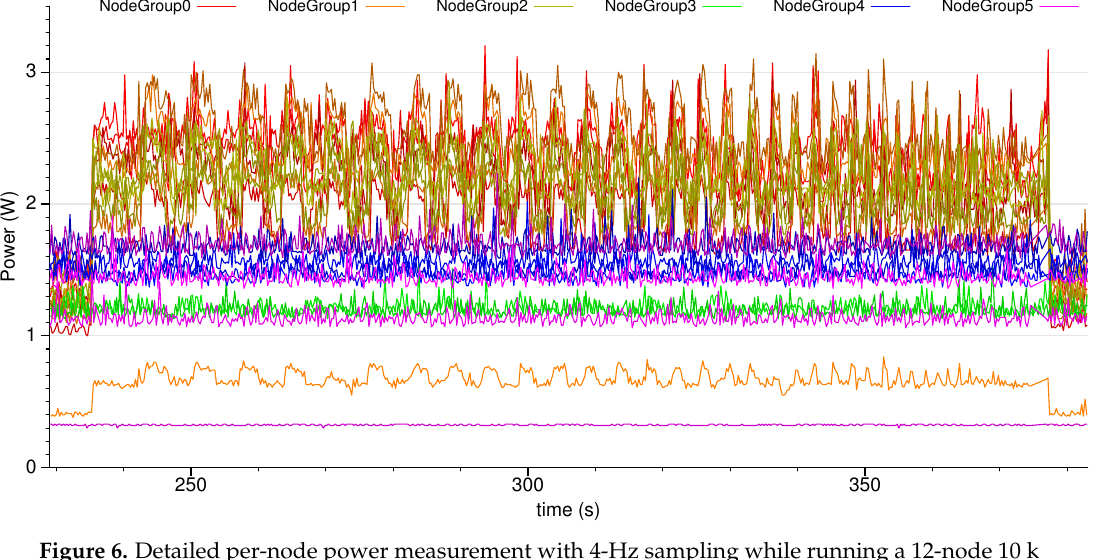
Figure 6. Detailed per-node power measurement with 4-Hz sampling while running a 12-node 10 k HPL (high-performance Linpack) run. All 24 nodes are shown, but only half are being used, which is why 12 remain at idle throughout the run. node05–2 is currently down and node03–0 , node03–3 and node01–0 have malfunctioning power measurement.